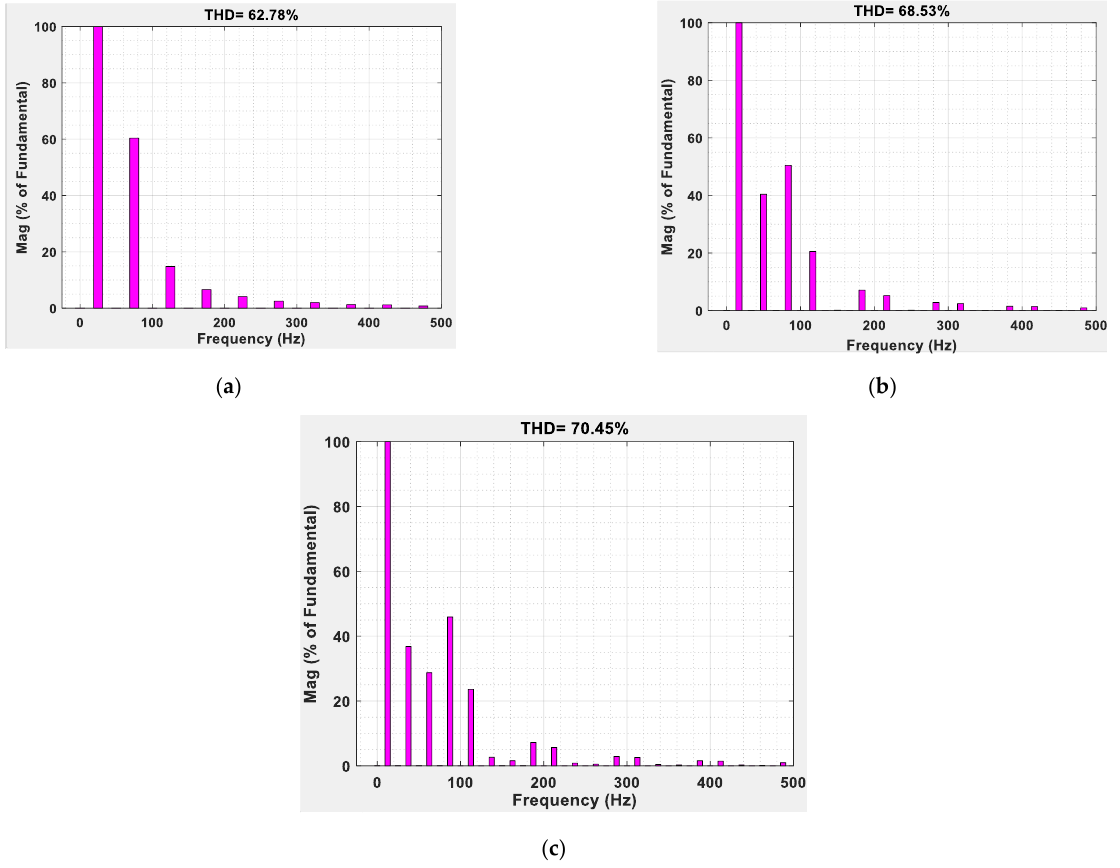
Figure 13. FFT spectrum of the output voltage without output voltage regulation capabilities for output frequency requirement: ( a ) one-half; ( b ) one-third; ( c ) one-fourth.